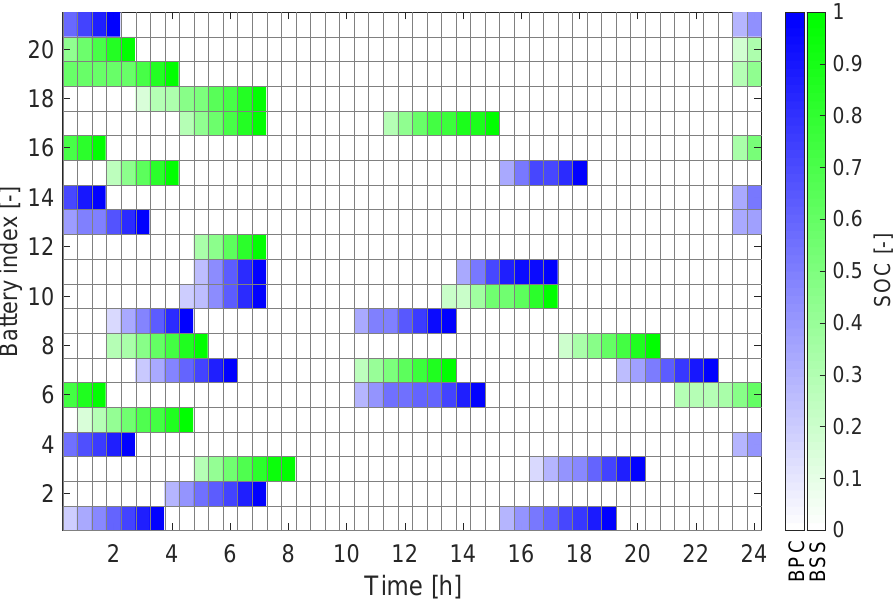
Figure 16. Battery state of charge time evolution at LGAV for the average day case (400 kW